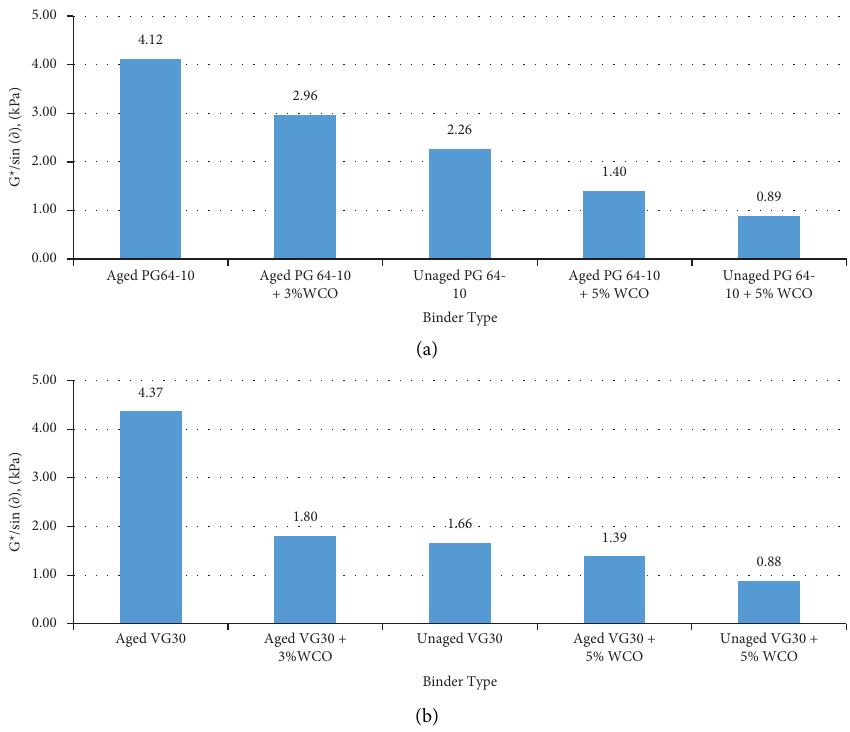
Figure 4: Efect of WCO addition on rutting parameters: (a) PG 64-10; (b)